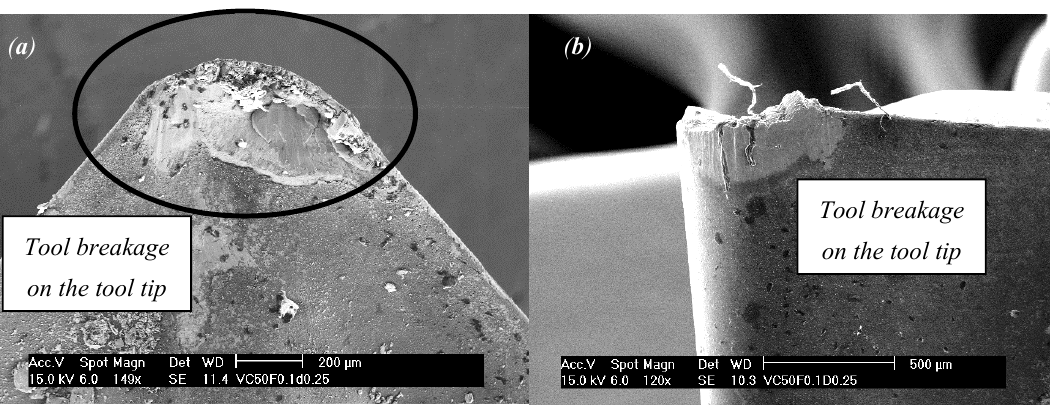
Figure 8. SEM images of the carbide tool supplied by Seco corresponding to the end of tool life with cutting speed 50 m/min, feed 0.1 mm and depth of cut 0.25 mm. ( a ) Tool breakage viewed from the rake surface; ( b ) Tool breakage viewed from the relief surface. Table 4. Results of tool life and machined surface per cutting edge for all tests conducted.